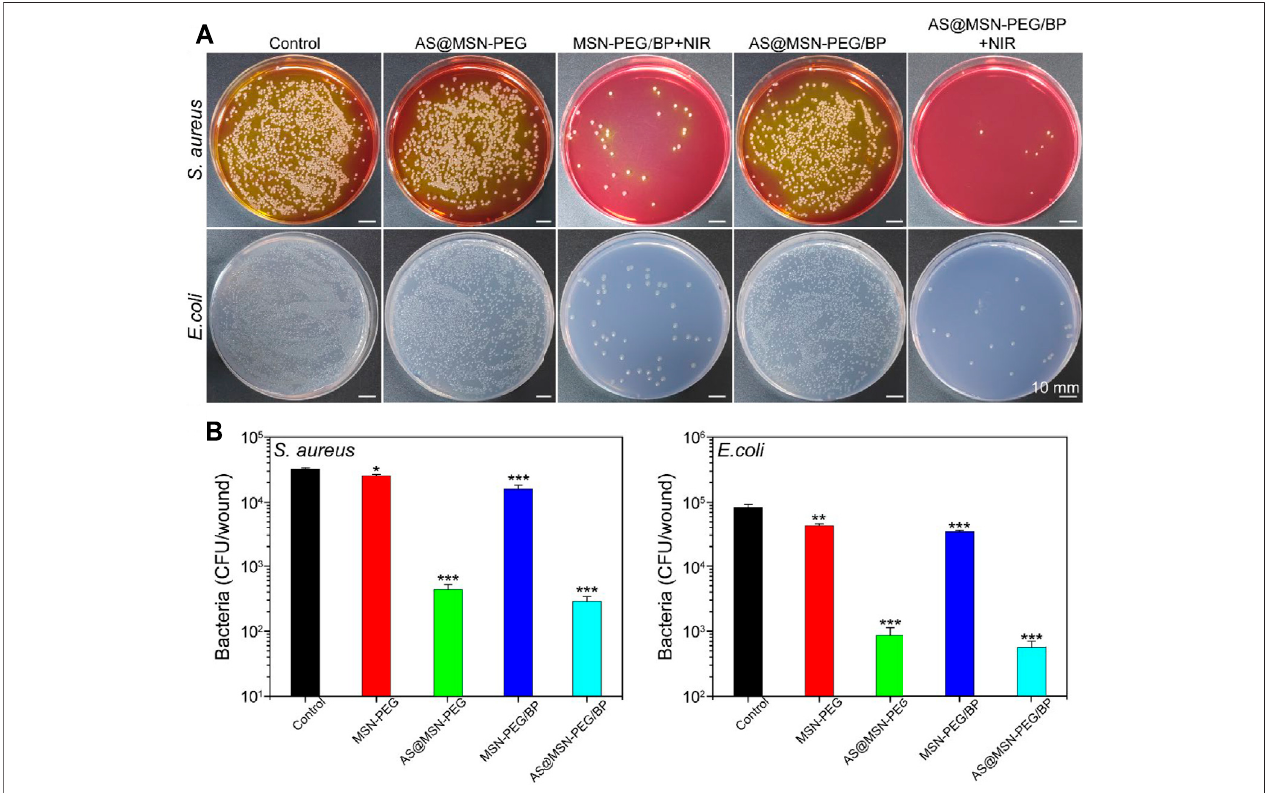
FIGURE5|(A) Digitalimagesof E.coli and S.aureus bacterialcolony-forming units,obtainedfromthewoundtissue(day3)undervarious experimental conditions (Control,MSN-PEG@AS,MSN-PEG@BP+NIR,MSN-PEG@AS/BP,andMSN-PEG@AS/BP+NIR). (B) Quantitativeresultsofstandardplatecountingassayafter24 h ( n =